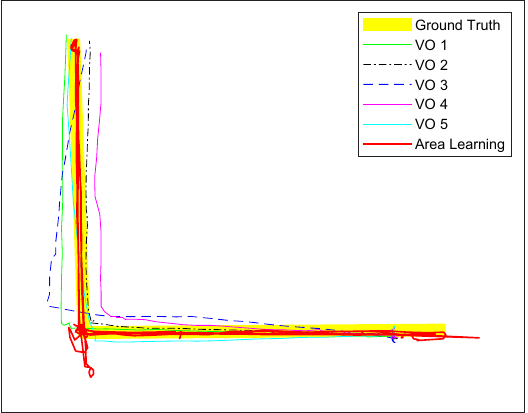
Figure 9. The ground truth and trajectory of test trails.